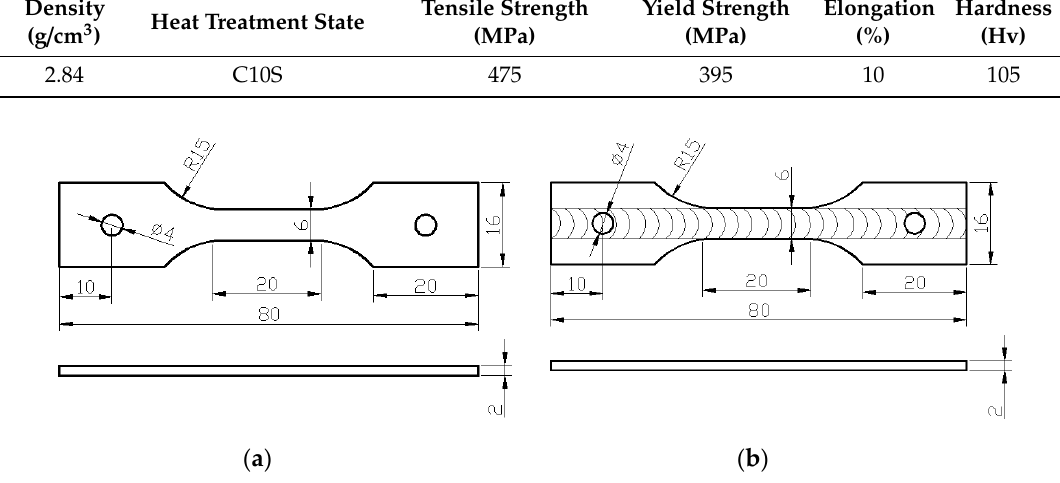
Figure 1. Schematic showing size and shape of test specimen used for the corrosion test. ( a ) Test specimen of the base metal; ( b ) test specimen containing the friction stir welding (FSW) joint.